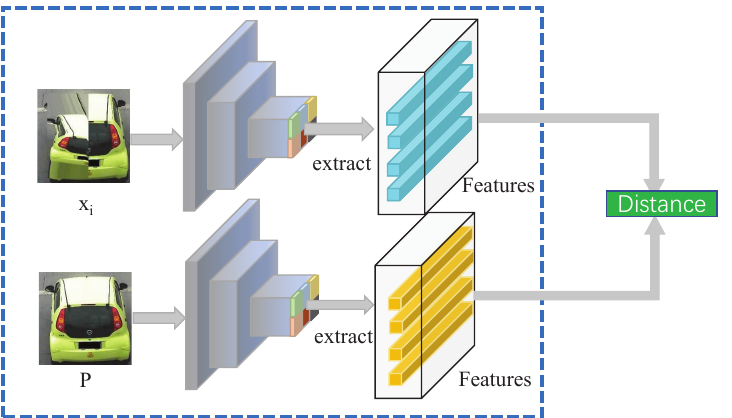
Figure 6. Distance of different images. The augmented samples x i are matched with the input image one by